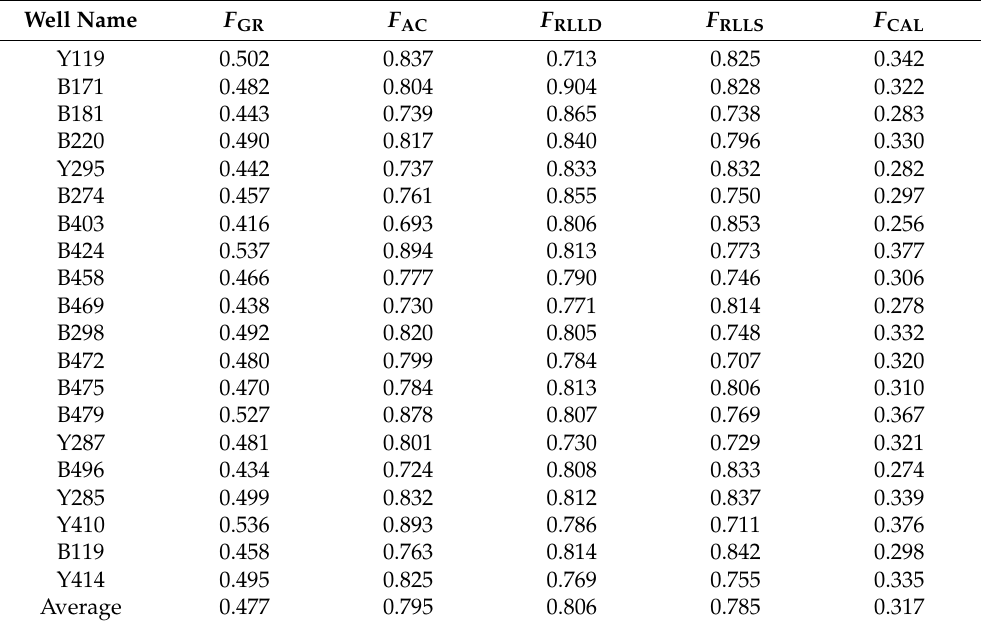
Table 1. Average of fracture indication values for a single logging property from 20 wells at core observed fracture